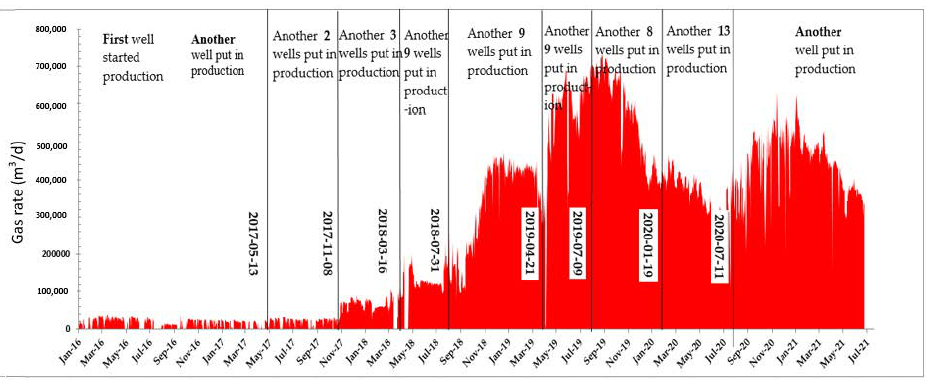
Figure 1. Production history of the Y